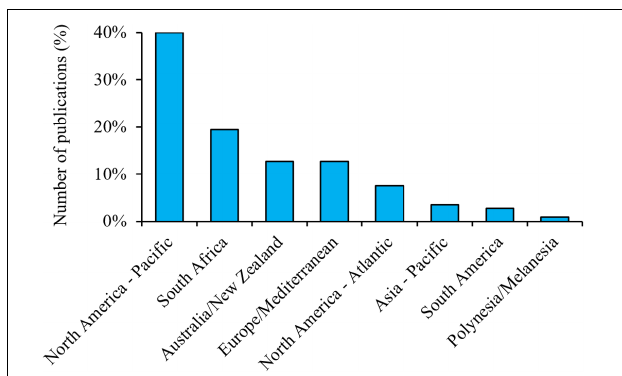
FIGURE 4 | Number of publications (all years) about white sharks per region based on a Web of Science search (12 June 2018) for items with titles including “white shark(s)” and/or “ Carcharodon carcharias .” N =